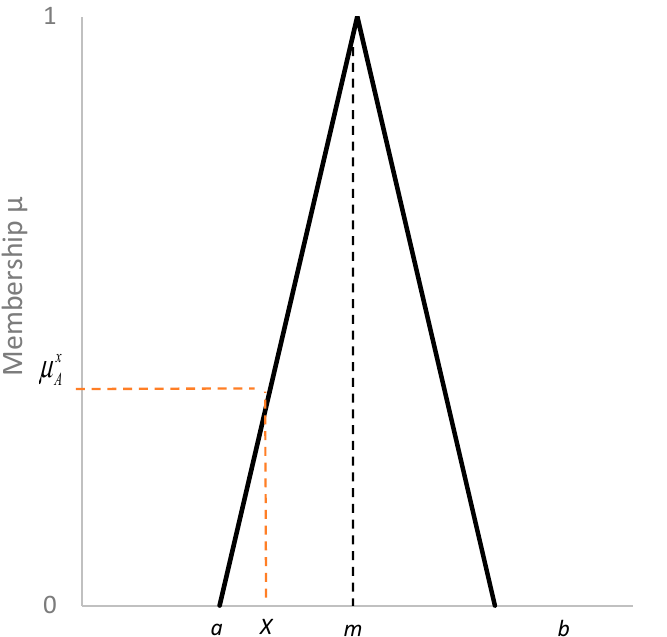
Figure A3. Triangular fuzzy membership function.